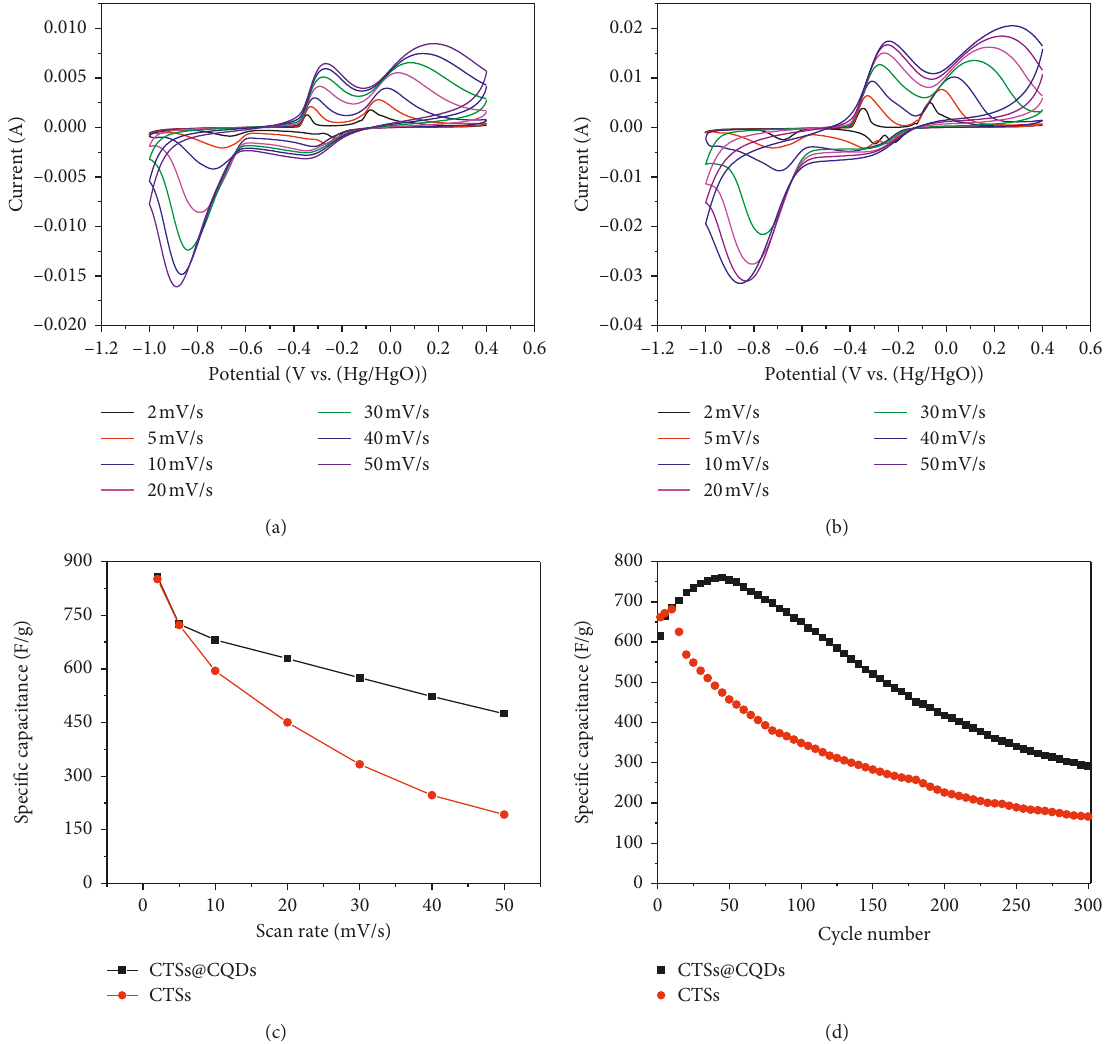
Figure 3: (a, b) CV curves of CTSs and CTSs@CQDs. (c) Rate capability of CTSs@CQDs and CTSs. (d) Cycling performance of CTSs@ CQDs and CTSs at the current density of 10A · g − 1